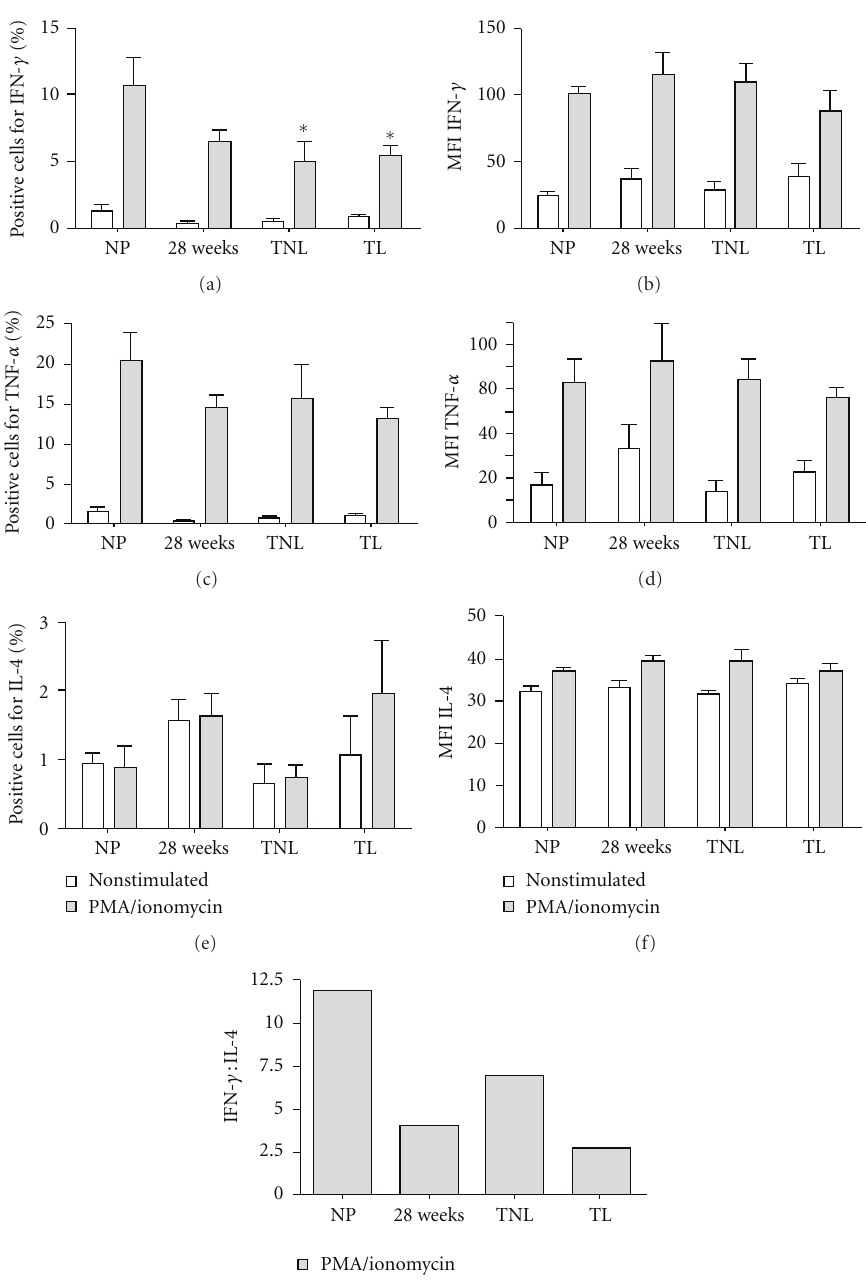
Figure 1: Th1 and Th2 cytokine production in peripheral T cells from nonpregnant and pregnant women. Peripheral blood mononuclear cells were isolated and stimulated with PMA/ionomycin. The percentage of CD4 + /IFN- γ + , CD4 + /TNF- α + , and CRTH2 + /IL-4 positive cells were detected by flow cytometry in samples derived from nonpregnant (NP), 28-week pregnant, term no labour (TNL), and term labour (TL) samples (a), (c), and (e). A reduction in the percentage of peripheral CD4 positive cells secreting the Th1 cytokines IFN- γ and TNF- α was observed, whereas the percentage of cells secreting the Th2 cytokine, IL-4, remained consistent throughout gestation. Mean fluorescence intensity (MFI) was also assessed as a measure of total cytokine production (b), (d), and (f). PMA/ionomycin stimulation induced both Th1 and Th2 cytokine production in all sample groups compared to NL controls. No di ff erences in gestation-dependent responses were detected. (g) a ratio of IFN- γ :IL-4 revealed a decrease in the Th1:Th2 ratio during pregnancy, which was increased prior to the onset of labour. For statistical analysis ANOVA with Dunnett’s multiple comparison test with NP as a control was used; ∗∗ P < 0 . 01 and ∗ P < 0 .